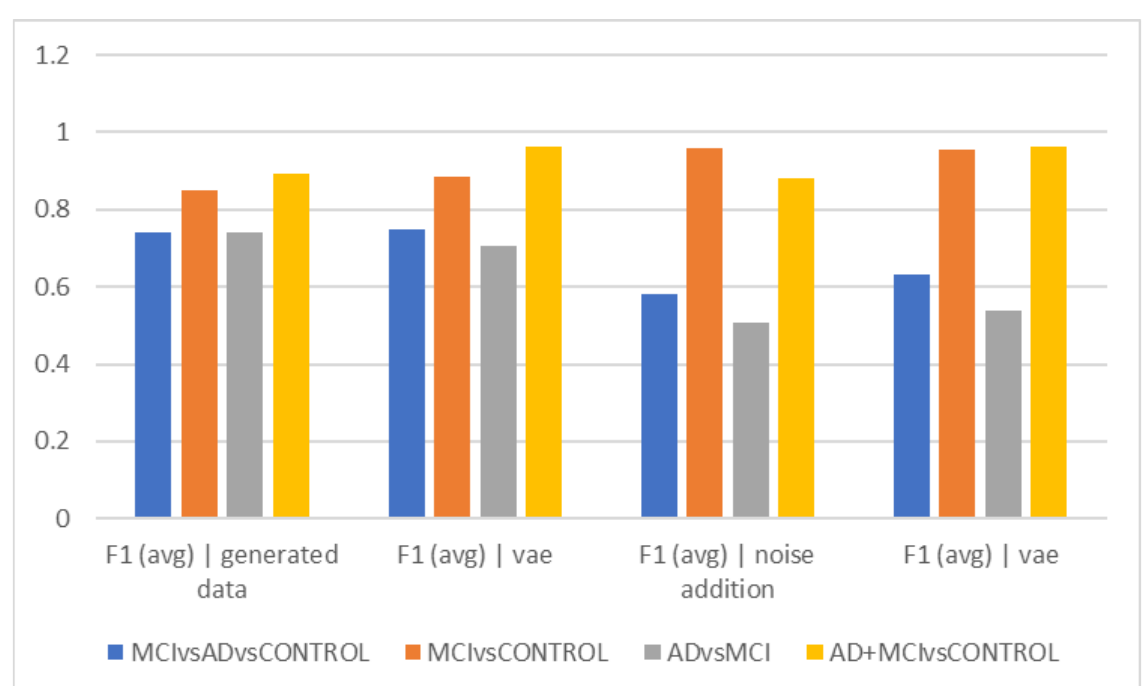
Figure 6. Comparison of results for a period of 15 s (accuracy).